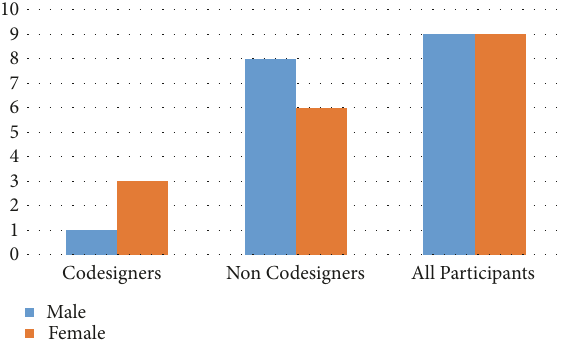
Figure 11: Genre distribution among the testers.